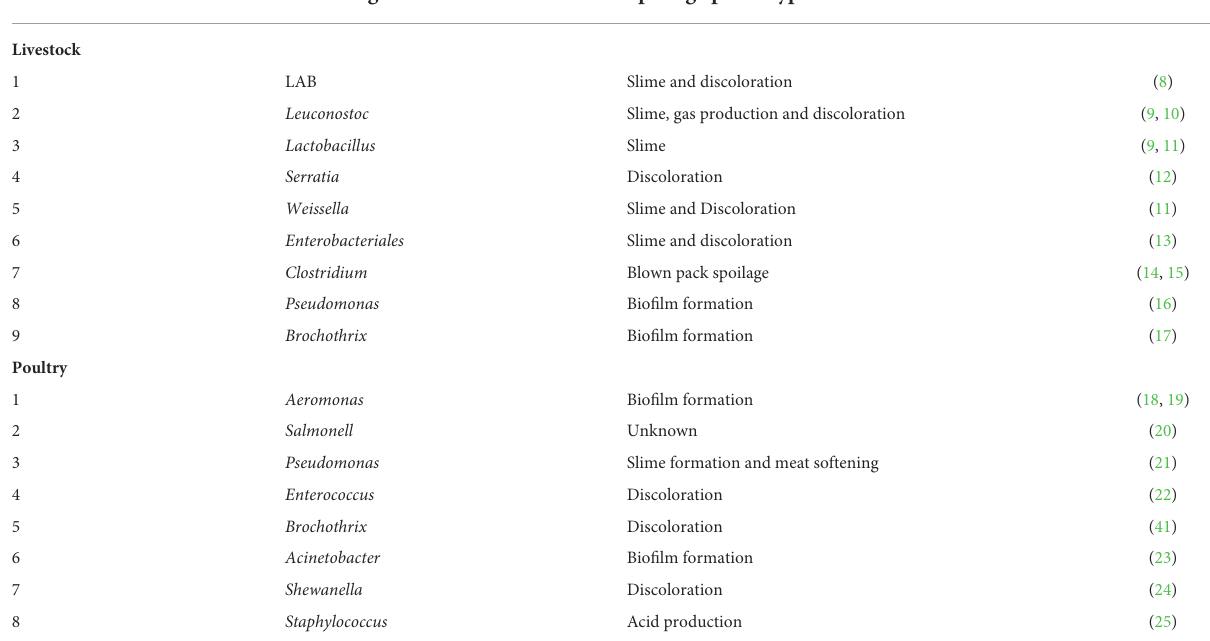
TABLE 1 List of bacterial groups associated with livestock and poultry